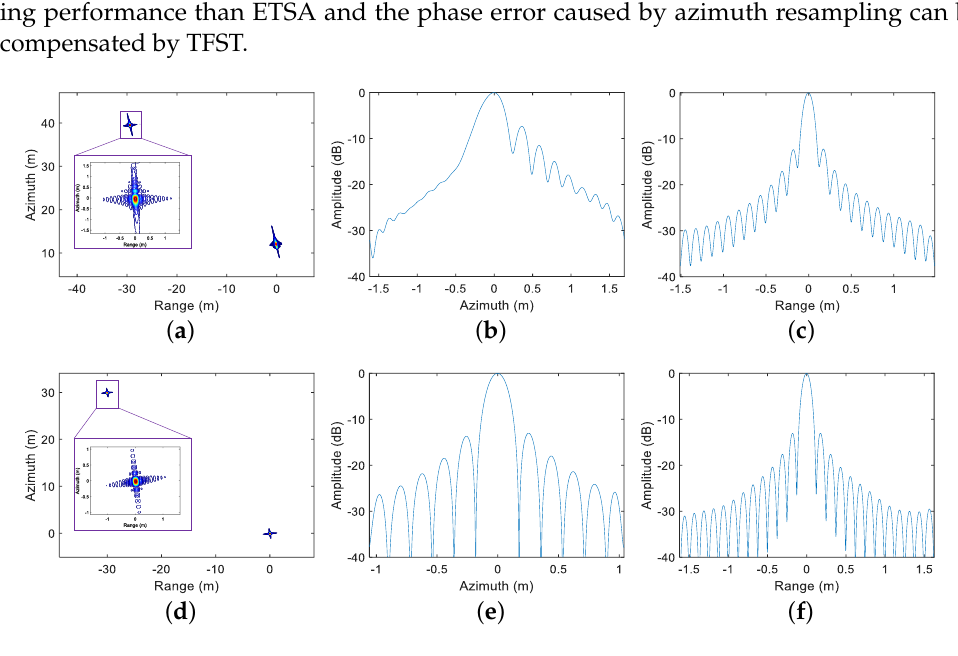
Figure 12. Contour plots (first column) for the two point targets P10 and P11. Azimuth (second column) and range profiles (third column) of the impulse response function for the point target P10.